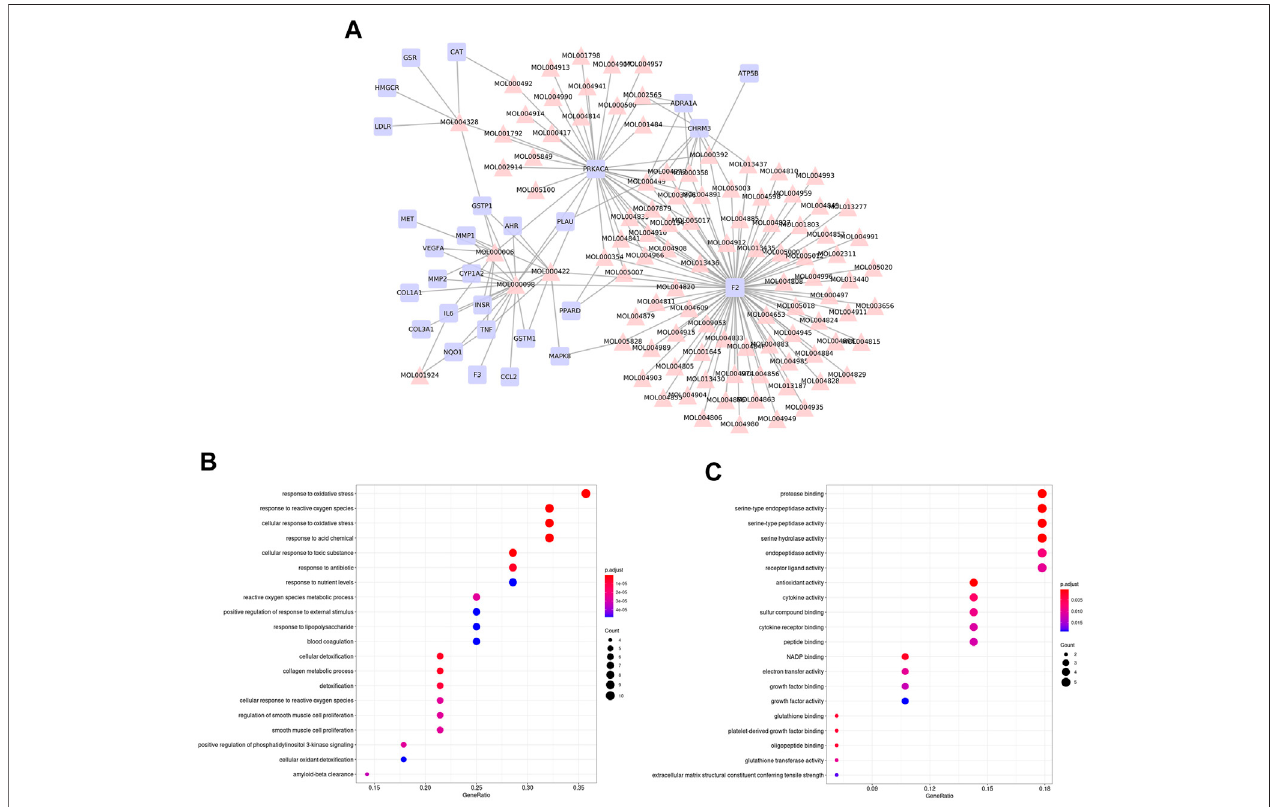
FIGURE 4 | Overlapped genes-based analysis. (A) Compound-target network of SNS against NAFLD. Gene ontology (GO) enrichment analysis of overlapped genes: (B) biological processes (BPs) and (C) molecular functions (MFs).